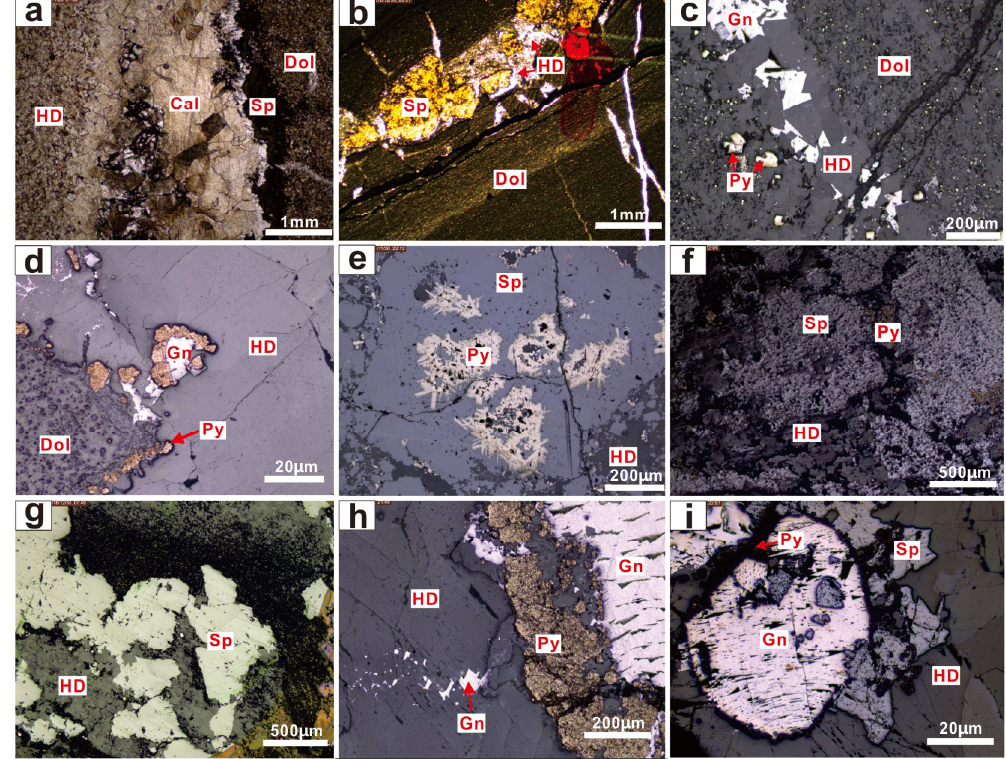
Figure 5. Microphotographs of representative samples from the Nayongzhi deposit. ( a ) Sphalerite and calcite intergrowth with hydrothermal dolomite. ( b ) Euhedral sphalerite and hydrothermal dolomite fill the fractures of dolostone. ( c ) Galena and pyrite fill the fractures of dolostone. ( d ) Galena wrapped by pyrite and hydrothermal dolomite. ( e ) Sphalerite intergrowth with pyrite. ( f ) Pyrite fill the edge of euhedral sphalerite granule ( g ) Euhedral sphalerite is around by hydrothermal dolomite. ( h ) Galena intergrowth with pyrite. ( i ) Galena replaced by sphalerite. Photomicrographs (a,b) were taken under transmitted plane-polarized light, and (c–i) were taken under reflected plane-polarized light. Abbreviations: Sp sphalerite; Gn galena; Py pyrite; Dol dolostone; HD hydrothermal dolomite; Cal calcite.